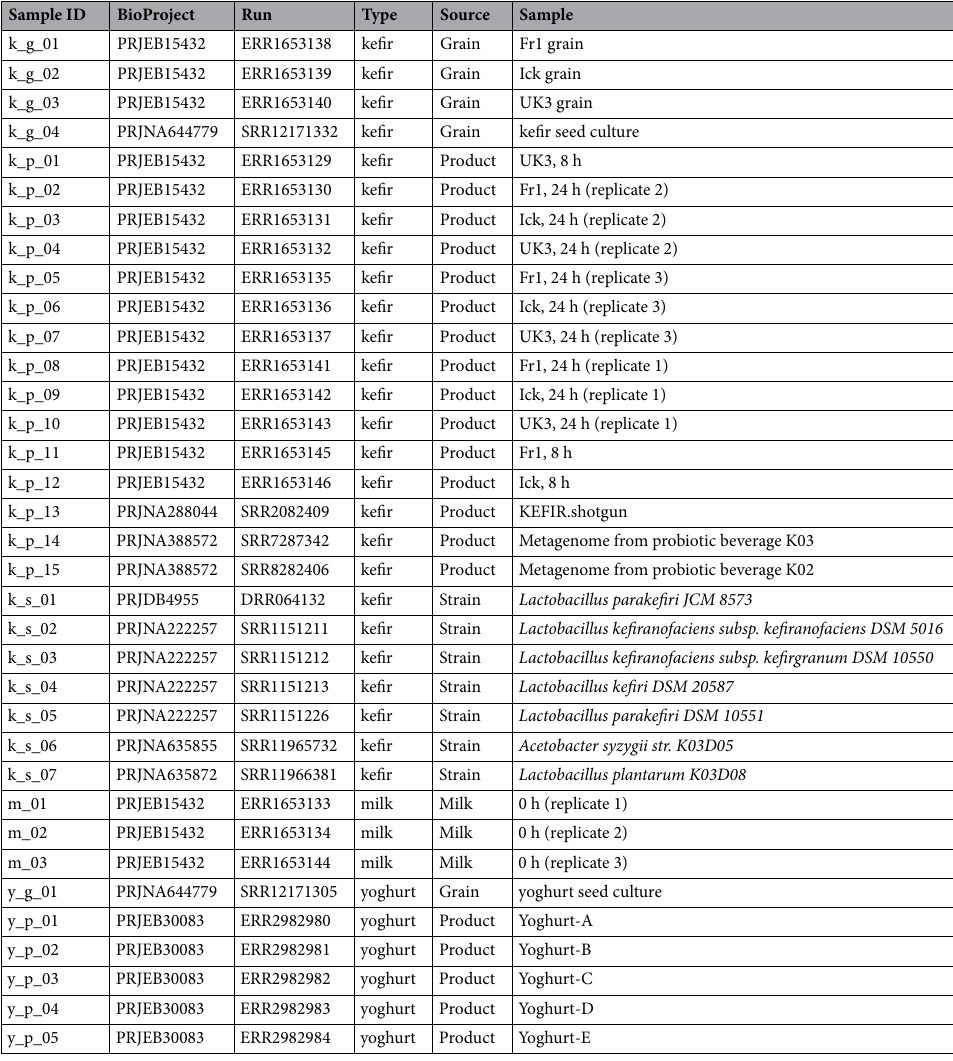
Table 1. The list of analyzed samples obtained from NCBI SRA. In the unified names of the samples the first character corresponds to the type of the sample (k and y, kefir and yoghurt, respectively), the second character comes from the first letter of the source (g, p and s for grain, product and strain, respectively), while the last tag is a sequence number. The last column shows the available attribute data of the